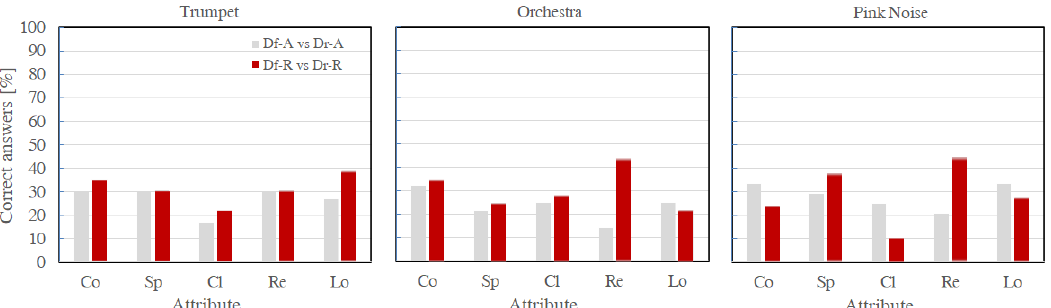
Figure 11. Listening test results. The listeners’ subjective evaluations on the perceived differences between front and rear location of the diffusive surfaces in the absorptive and reflective conditions (Df-A vs. Dr-A and Df-R vs. Dr-R). The y -axis depicts the occurrences of each attribute given in the correct answers. The x -axis reports the attributes Co—coloration, Sp—spaciousness, Cl—clarity, Re—reverberance, Lo—loudness.